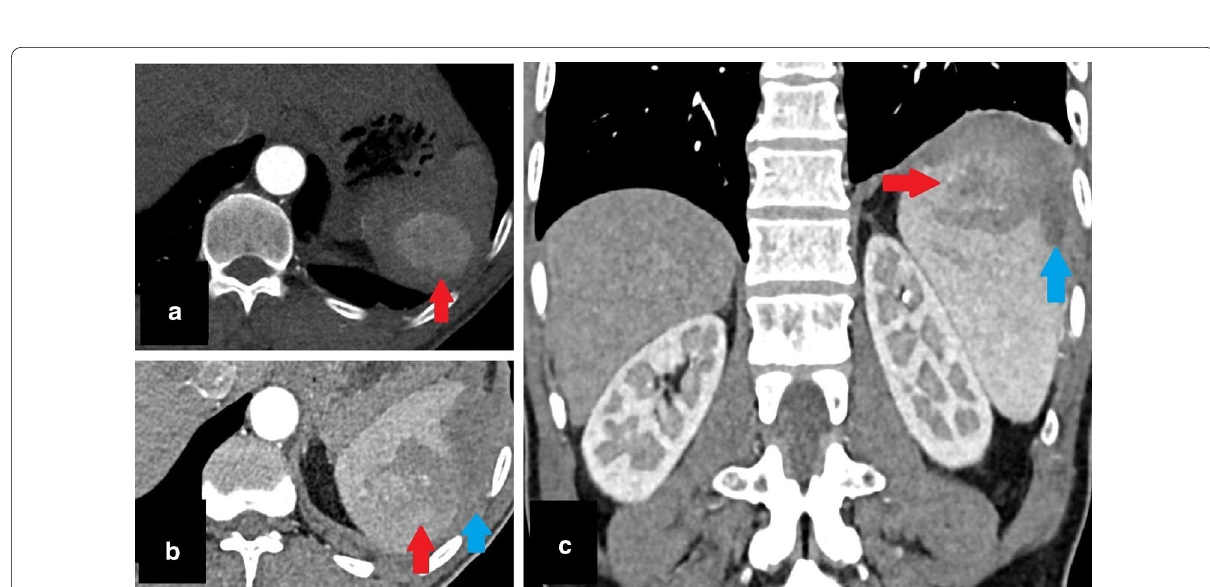
Fig. 24 Delay in diagnosis with a life-threatening condition. A 47-year-old male patient presented with complaints of chest pain and abdominal discomfort. History and clinical examination suggested cardiovascular etiology as a possible underlying cause. Coronary CTA was ordered to evaluate the presence of coronary artery disease. The coronary arteries were reported as normal. However, a well-defined splenic hypervascular lesion was missed due to the “edge effect”. The lesion was seen only on the last few slices of “the CT images with a large field of view” (red arrow, a ). One week later, the patient was admitted to the ER with severe left upper quadrant pain. Abdominal CECT revealed a ruptured lesion (red arrows, B, c ) and subcapsular splenic hematoma (blue arrows, b , c ) with active extravasation (not